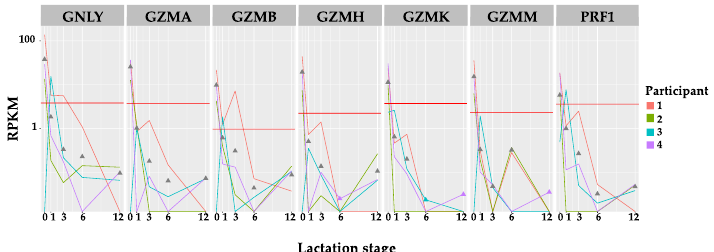
Figure 1. Expression of the genes encoding granzyme A (GZMA), granzyme B (GZMB), granzyme H (GZMH), granzyme M (GZMM), granulysin (GNLY) and perforin (PRF1) expressed in Reads Per Kilobase per Million mapped reads (RPKM) in longitudinal human milk cells (coloured lines) and pooled resting mammary tissue (RMT) (straight red line). Four lactating participants provided pre-partum secretion (PS) cells and four subsequent human milk cell samples at months 1, 3, 6 and 12 of lactation. Average expression at each time point is represented by grey triangles. In general, there is a decrease over lactation period with the highest expression in the pre-partum secretions. Moreover, PS cells show higher gene expression for all immune proteins in comparison with RMT.